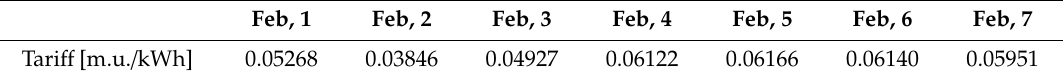
Table 3. Market price for the study period.